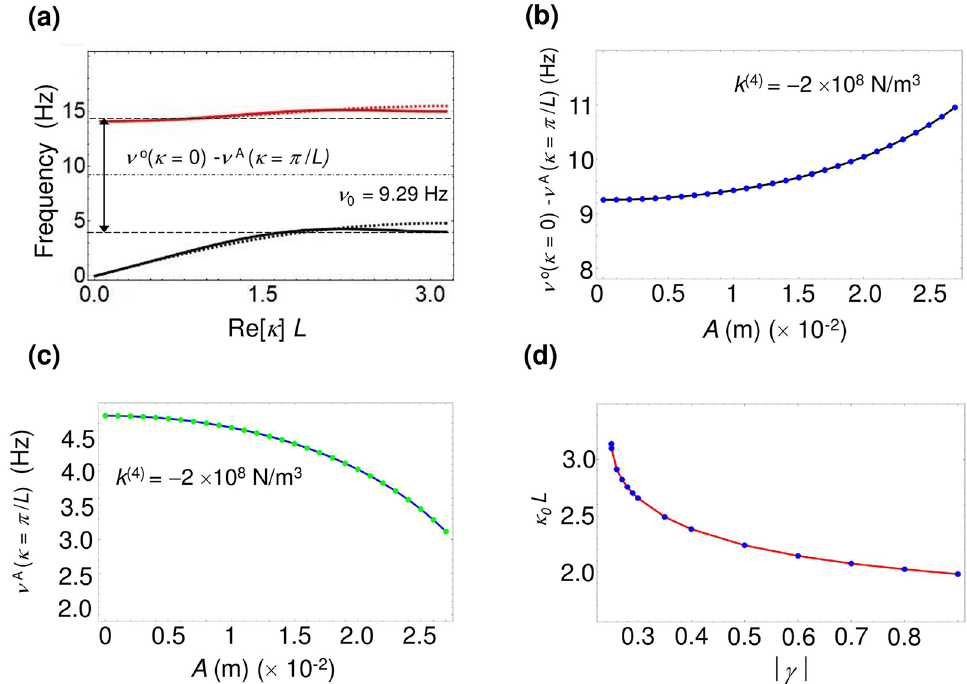
Fig. 3. (a) Frequency dispersion relation of the A mode (black lines) and of the O mode (red lines). The Bloch wave vector characterizing the propagating regime is labeled as Re[ k ]. Dotted lines: harmonic dispersion. Solid lines: nonlinear dispersion in the softening anharmonic regime for k (4) = (cid:1) 2 (cid:5) 10 8 N/m 3 . The double arrow indicates the “ BG ” amplitude at the 1BZ border in the latter case. The dash-dotted line labels the resonance frequency n 0 =9.29 Hz. (b) Continuous black line with full blue circles: difference between the frequency of the O mode at k =0 rad/m and the frequency of the A mode at k = p / L amplitude as a function of the wave amplitude A in the softening regime for k (4) = (cid:1) 2 (cid:5) 10 8 N/m 3 corresponding to the “ BG ” at the border of the 1BZ. (c) Continuous blue line with full green circles: frequency of the A mode at the 1BZ boundary, n A ( k = p / L ), as a function of the wave amplitude A in the softening regime for k (4) = (cid:1) 2 (cid:5) 10 8 N/m 3 . (d) Continuous red line with full blue circles: dimensionless wave vector k 0 L vs. modulus | g | of the anharmonic